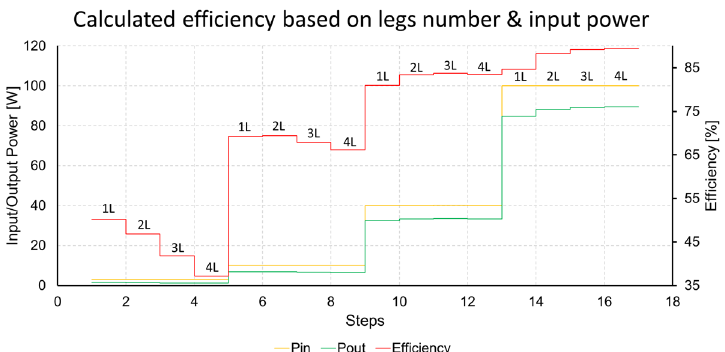
Figure 5. Efficiency results achieved by proposed equations for various converter legs number and input powers.